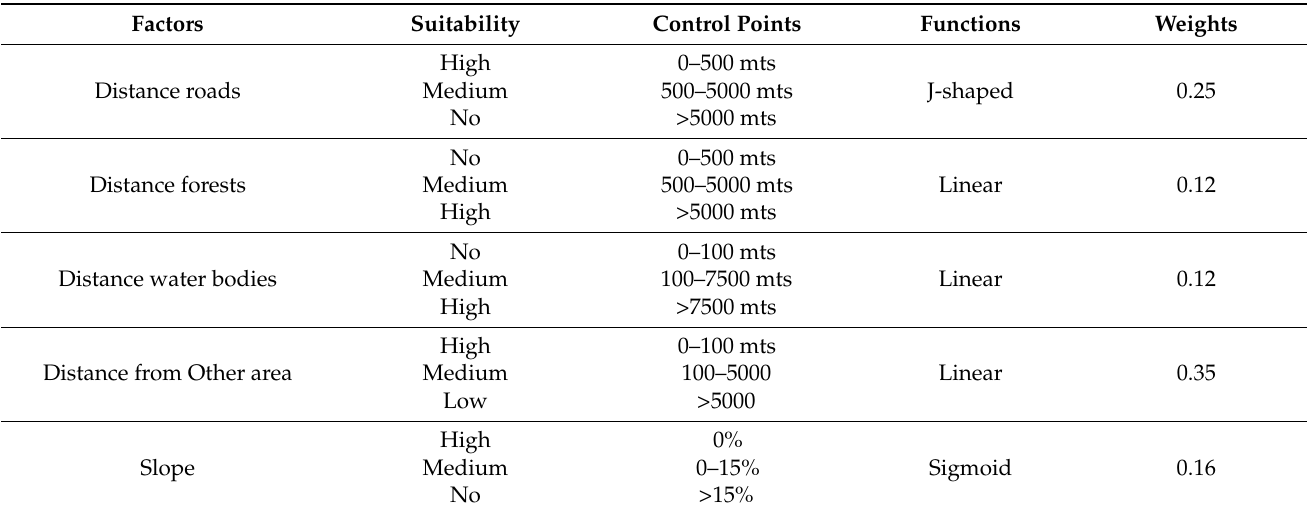
Table 3. Extracted weights based on AHP and fuzzy